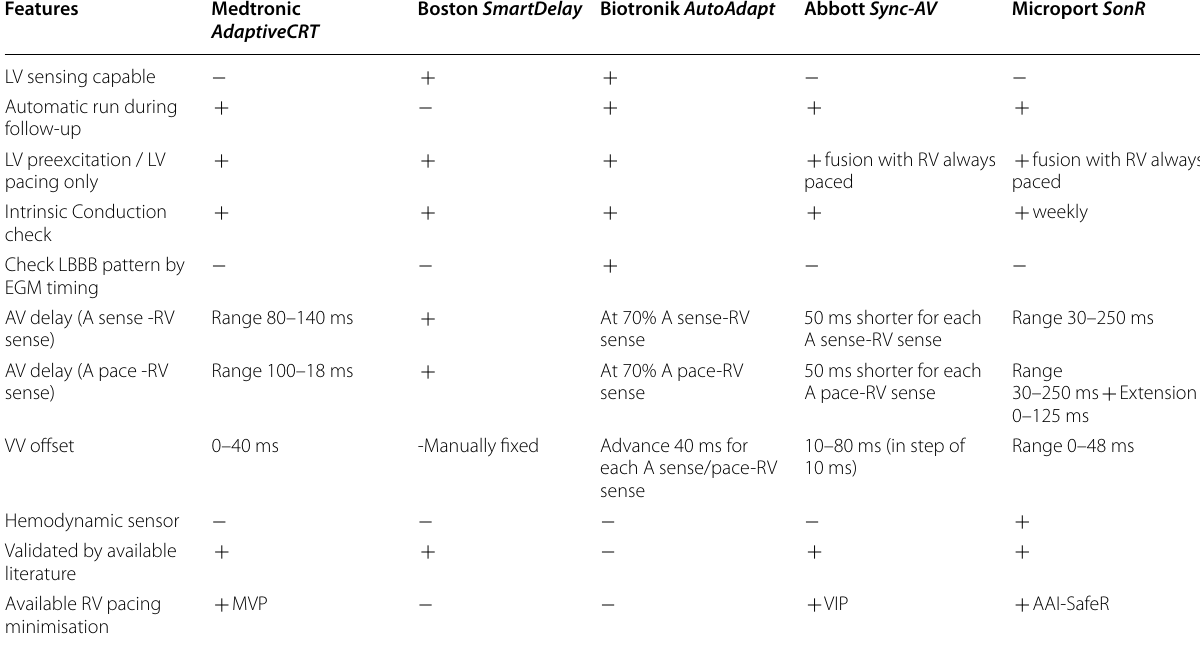
LBBB left bundle branch block; LV left ventricle (pacing); RV right ventricle (pacing); VV offset VV delay programming with LV-RV which means LV pacing advances the RV pacing or the opposite; EGM electrogram; MVP Medtronic automatic algorithm to minimise RV pacing; VIP Abbott automatic algorithm minimise RV pacing; AAI- Safe R Microport automatic algorithm to minimise RV